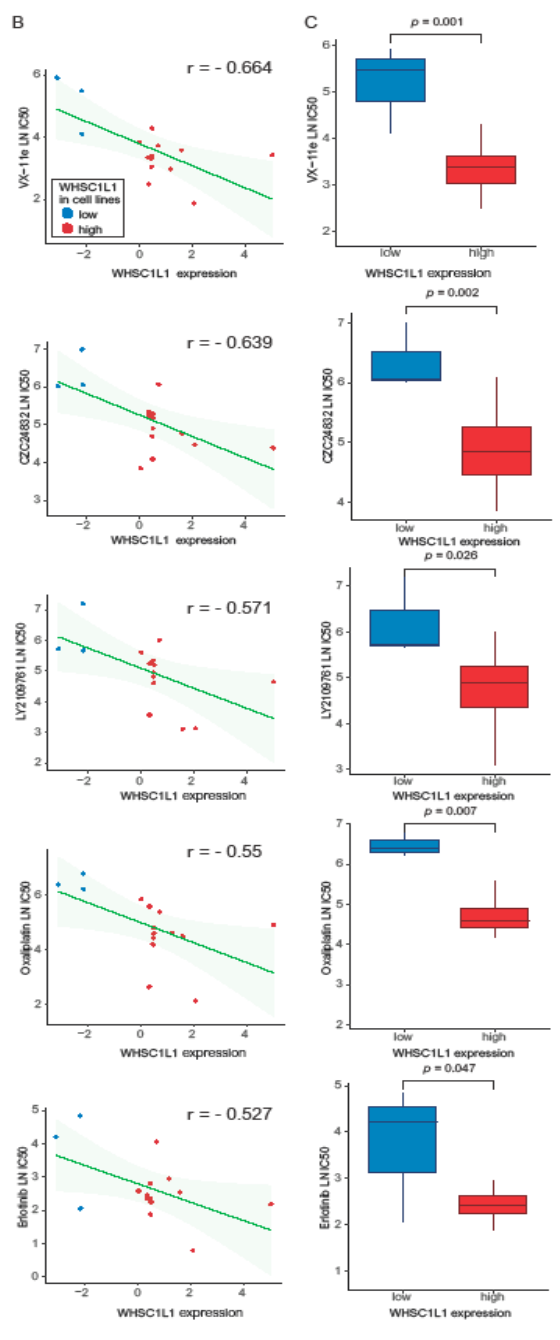
Figure 4. ( A ) We used the supervised machine learning model (gradient boosting machine) for prognosis prediction. Covariates were included as confounding factors (Model 1 (T stage, N stage, perineural invasion (PNI), histological grade (HG), estrogen receptor (ER) and lymphatic invasion (LI)) vs. Model 2 (WHSC1L1, T stage, N stage, PNI, HG, ER and LI)), and their relative importance was assessed using survival analysis. A receiver operator characteristic curve for GBM was used based on a multivariate Gaussian model. ( B ) Pearson’s correlation analysis showing the natural log of the half-maximal inhibitory concentration (LN IC50) values of VX-11e, CZC24832, LY2109761, oxaliplatin and erlotinib in breast cancer cells (blue, low WHSC1L1 expression; red, high WHSC1L1 expression). ( C ) Bar plot showing the LN IC50 values of VX-11e, CZC24832, LY2109761, oxaliplatin and erlotinib in breast cancer cells with low (blue) and high (red) WHSC1L1 expression ( p = 0.001, 0.002, 0.026, 0.007 and 0.047, respectively) (error bars: standard errors of the